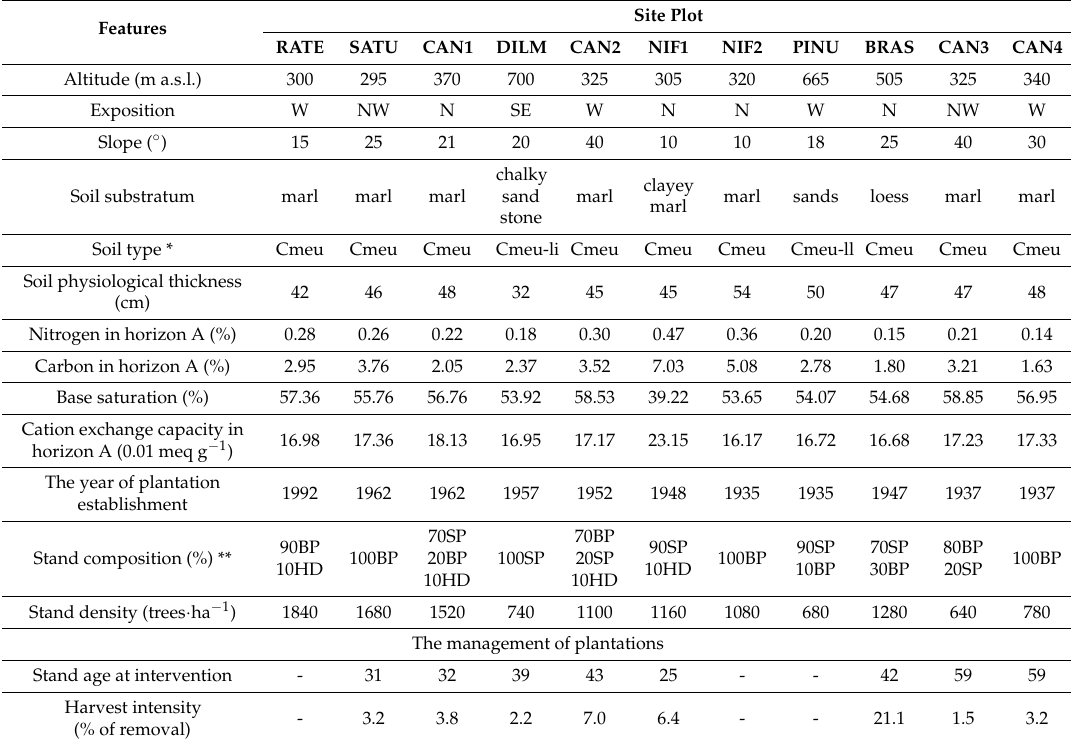
Table 1. Description of study